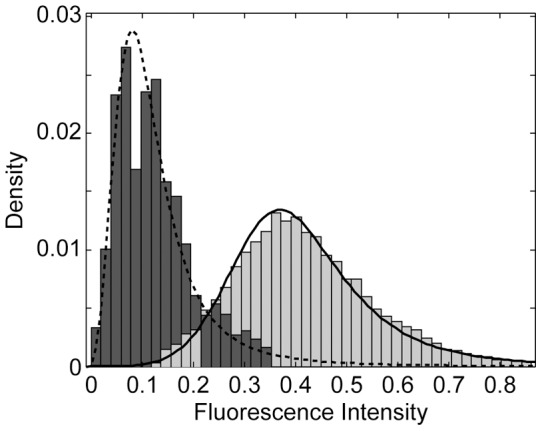
Fluorescence intensity of giant unilamellar vesicles (GUVs) and intact hierarchical unilamellar vesicles (HUVs).The fluorescence intensity of the lumen of immobilized released GUVs is shown in light gray. The fluorescence intensity of the membrane of intact HUVs is shown in dark gray. Lines represent log-logistic fits with mean 0.42 and standard deviation 0.16 (solid line) and mean 0.13 and standard deviation 0.13 (dashed line).